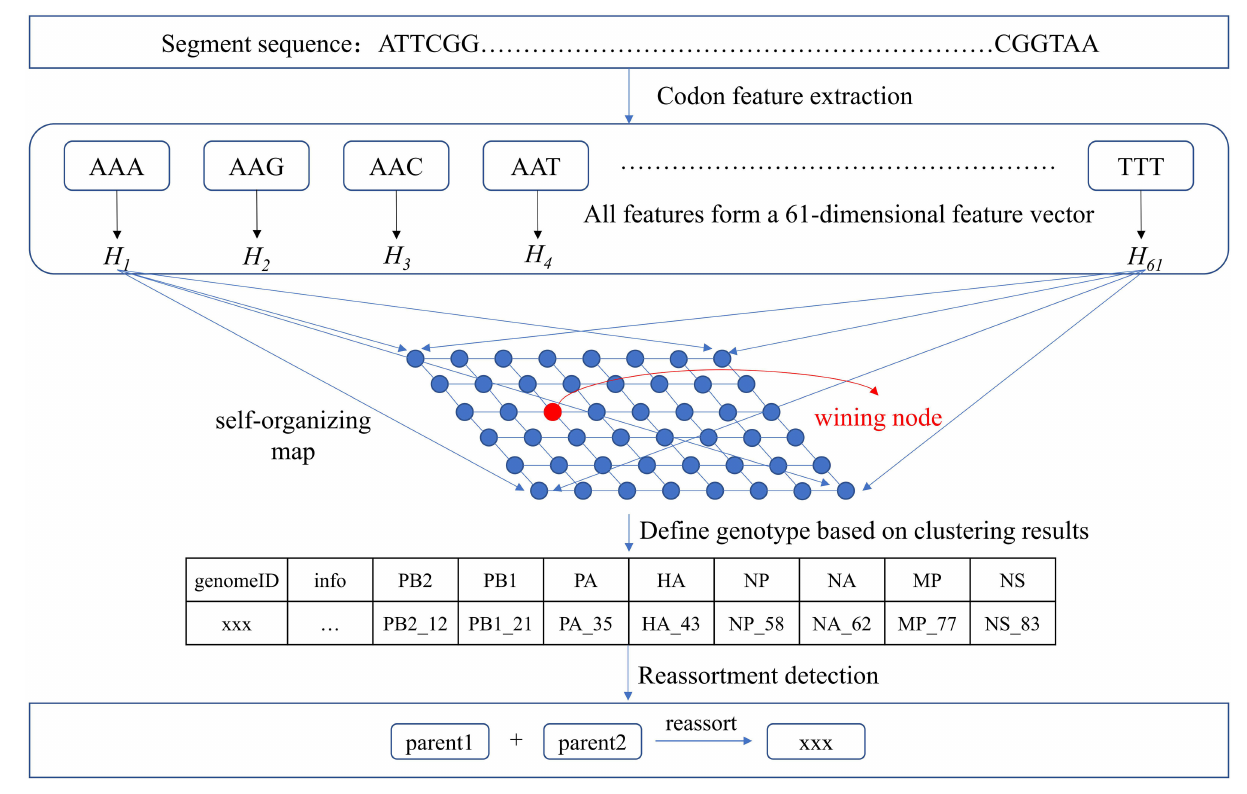
FIGURE 2 | Reassortment detection framework. Each segment sequence was represented as a 61-dimensional feature vector and was input to SOM for clustering. The genotype was defined and reassortment detection was performed combined with the epidemiological